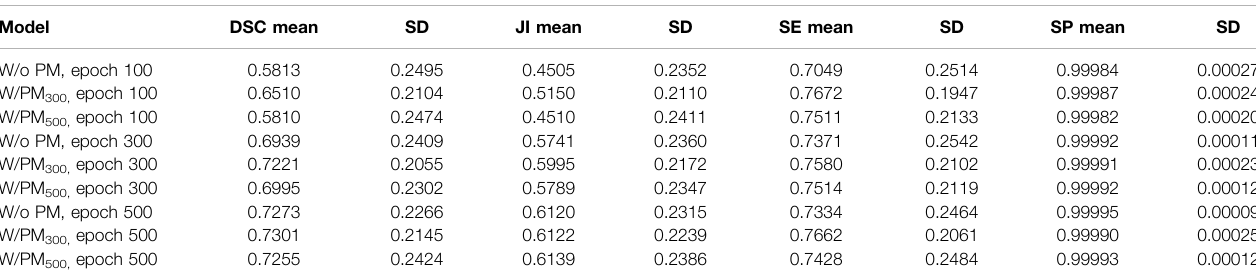
TABLE 2 | Segmentation metrics of test set using Decathlon full .